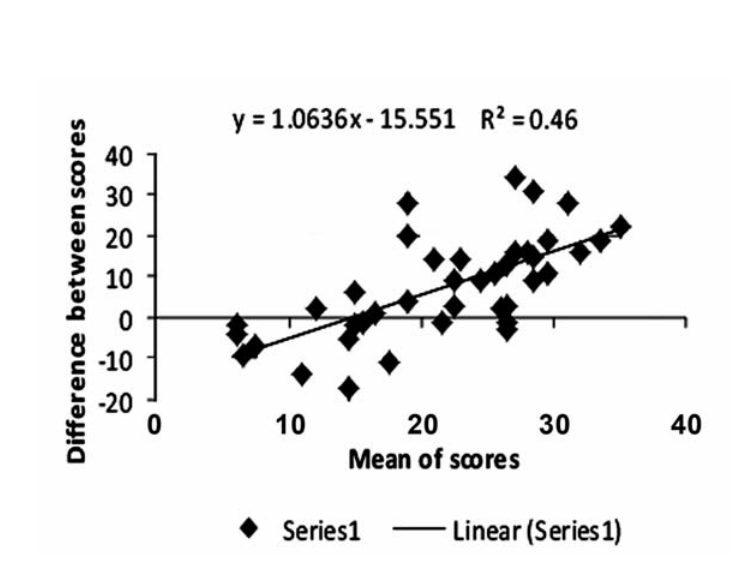
Figure 4. Bland Altman plot for Canadian Acute Respiratory Illness and Flu Scale and Paul et al.